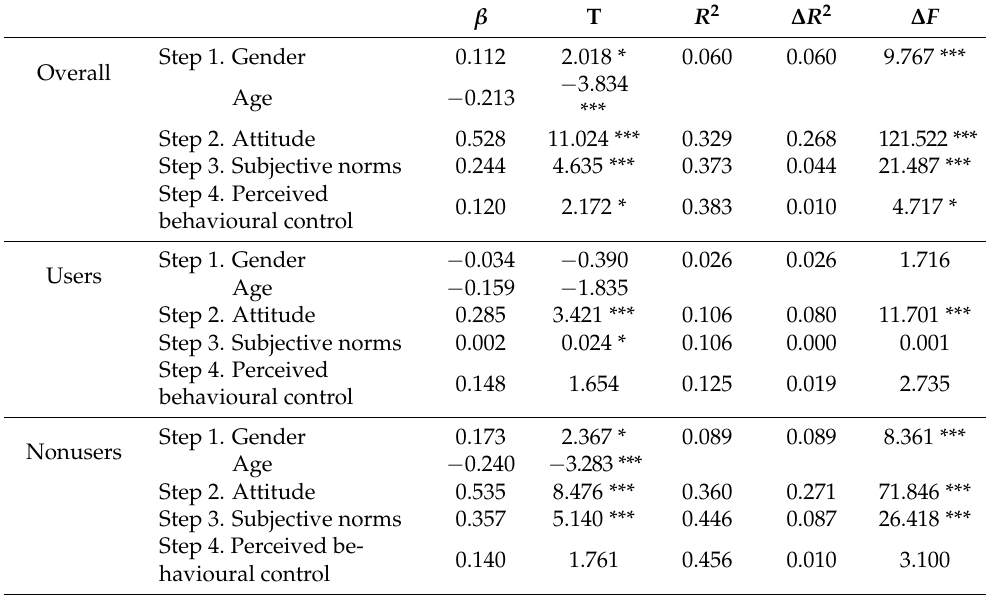
Table 2. Hierarchical regressions of behavioural intention on attitude, subjective norms, and perceived behavioural